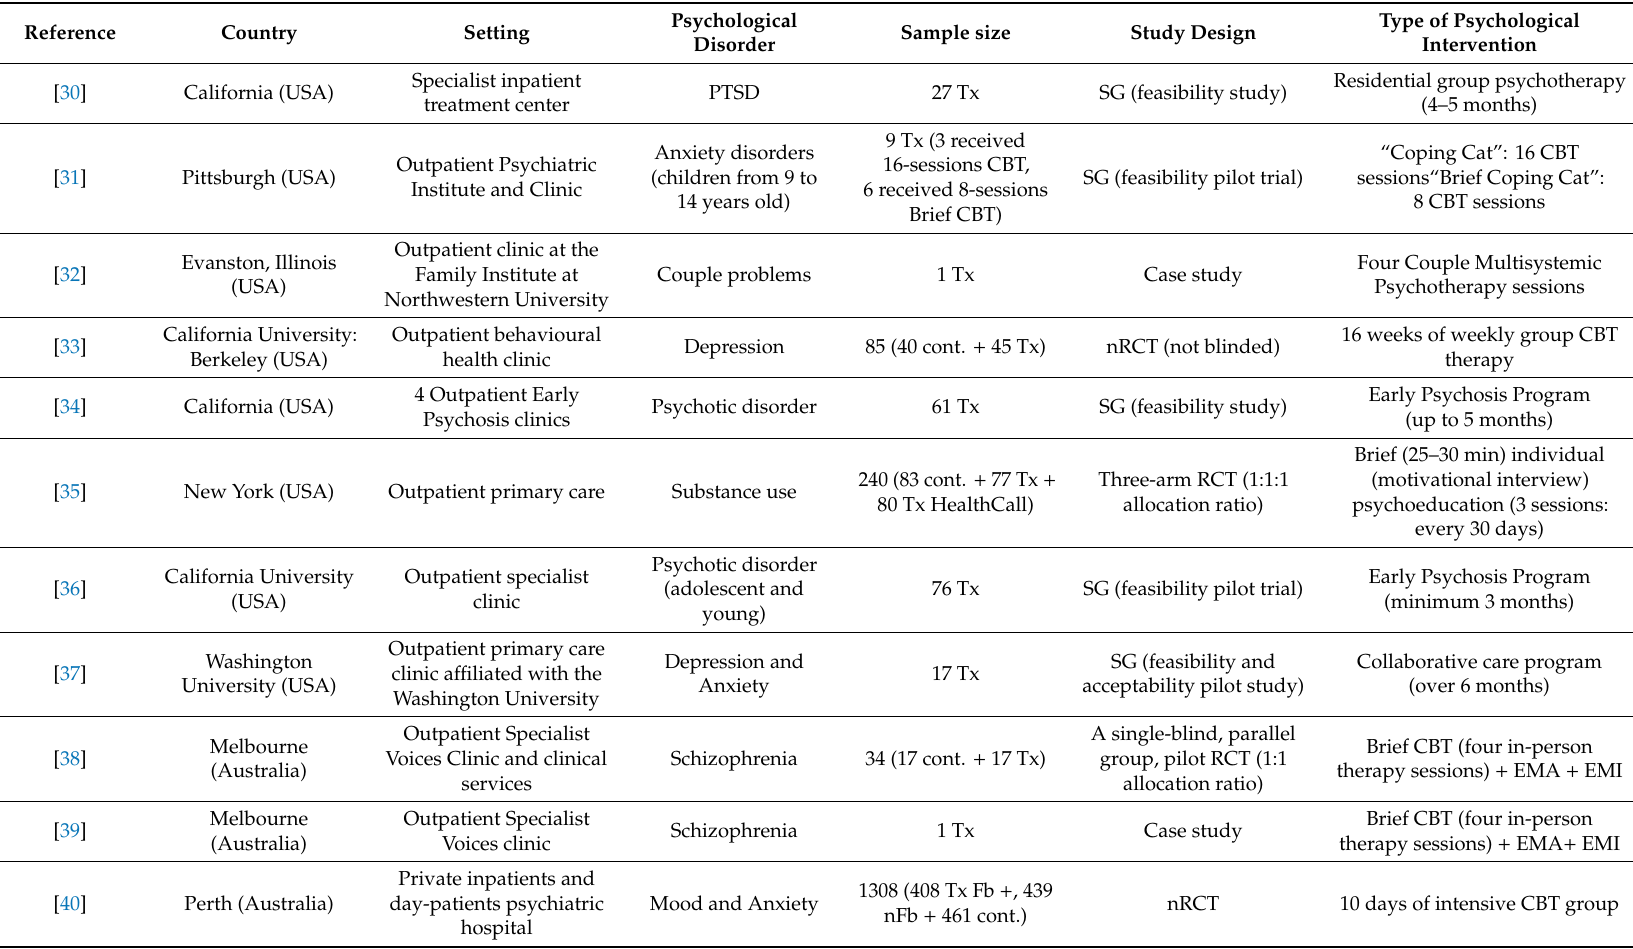
Table 1. Characteristics of the included